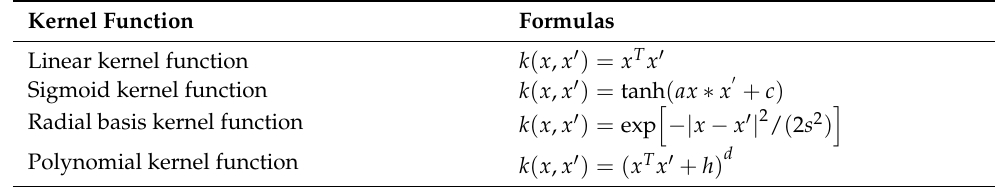
Table 2. Kernel functions in